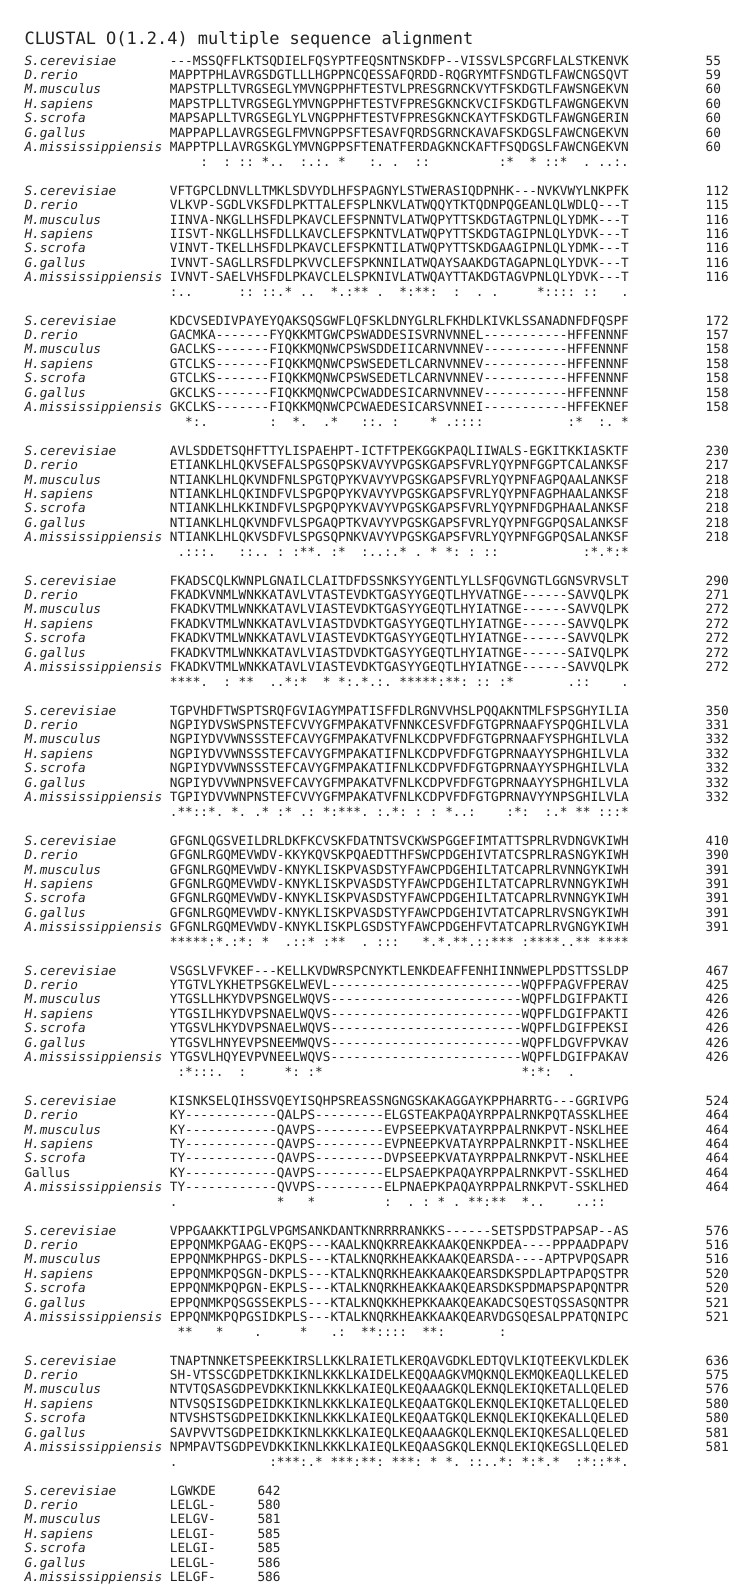
Figure 3. Representative sequence alignments of eIF2A proteins from yeast ( Saccharomyces cerevisiae ), zebrafish, ( Danio rerio ), mouse ( Mus musculus ), human ( Homo sapiens ), pig ( Sus scrofa ), chicken ( Gallus gallus ) and alligator ( Alligator mississippiensis